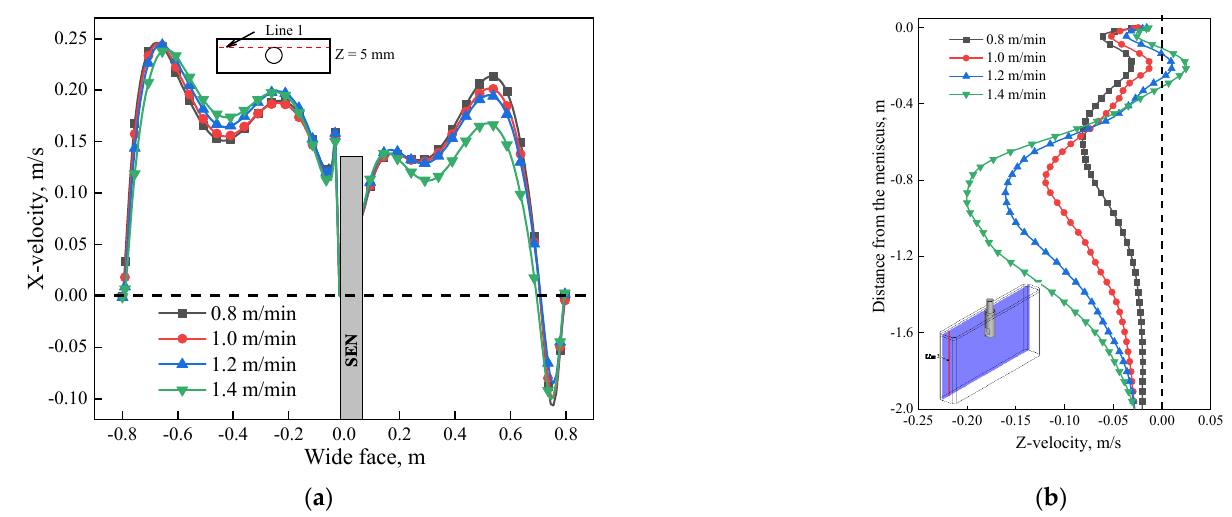
Figure 11. Variation of velocity under different casting speeds at (600 A, 4 Hz): ( a ) X-velocity at line 1, ( b ) Z-velocity at line 2.